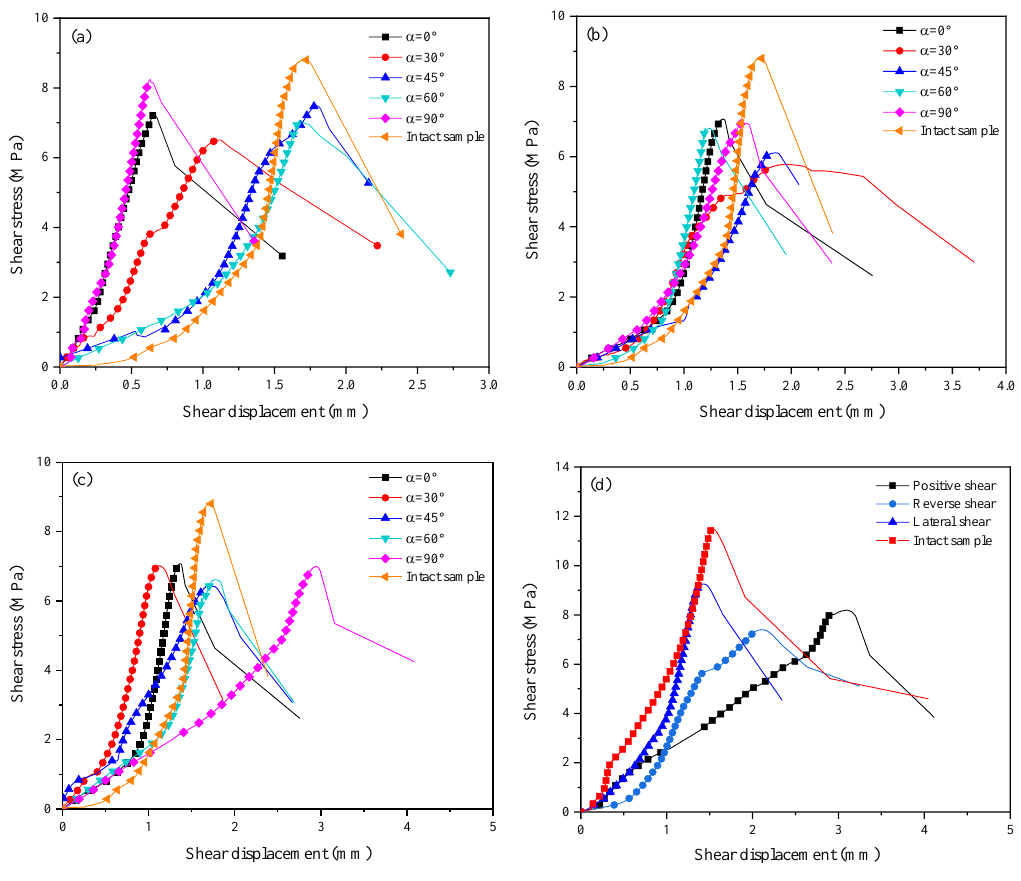
Figure 7. Shear stress-shear displacement curve: ( a ) positive shear, σ n = 2 MPa; ( b ) reverse shear, σ n = 2 MPa; ( c ) lateral shear, σ n = 2 MPa; ( d ) α = 45°, σ n = 4 MPa. Table 3. Mechanical characteristics of the samples at different inclinations and shear directions under the same normal stress ( σ n = 2